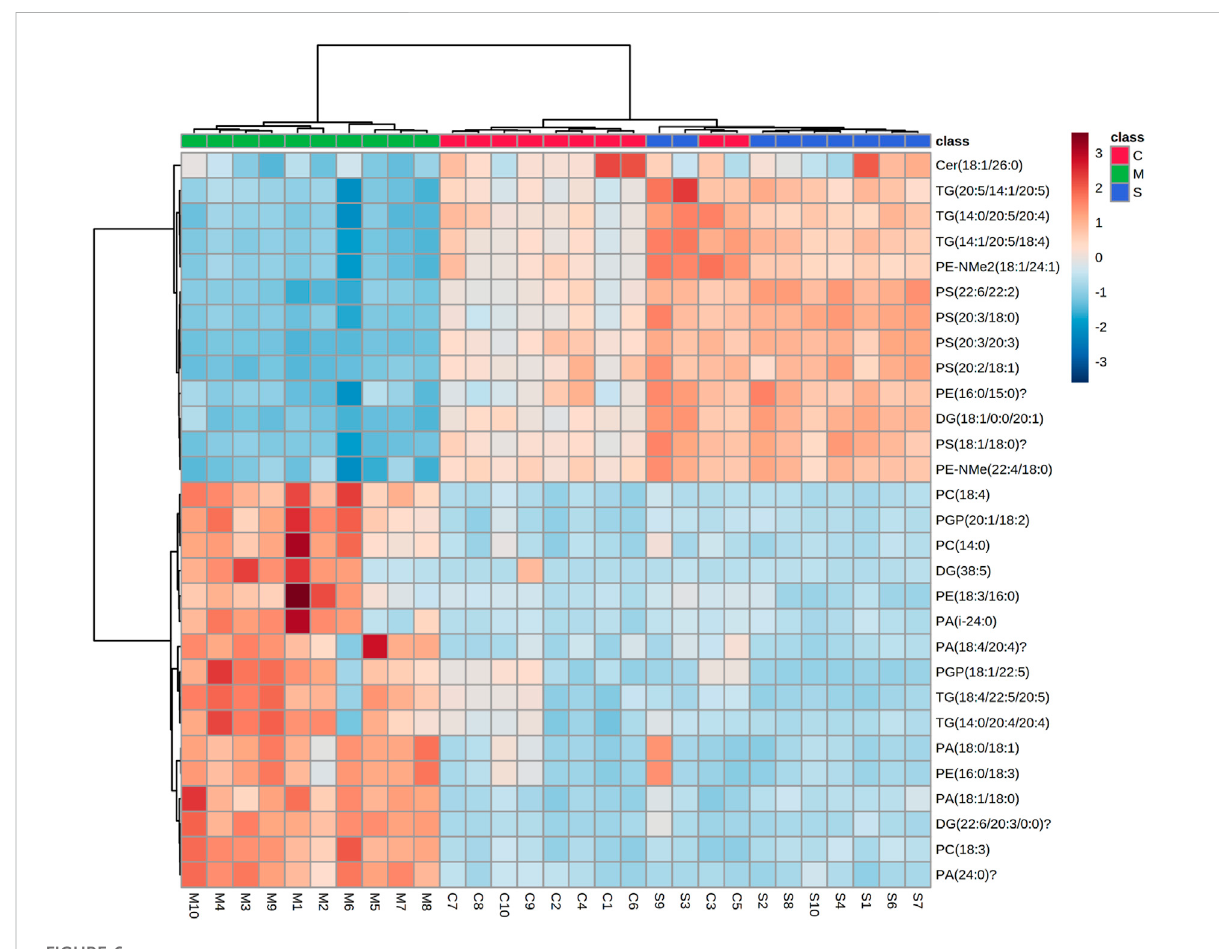
FIGURE 6 Heat map of the 31 differential lipid metabolites between the control (C1-C10) group, model (M1-M10) group and S (S1-S4 and S6-S10) group. Rows: samples; columns: metabolites. Dark red plots indicated upregulated metabolites and dark blue plots indicated downregulated metabolites in rats.